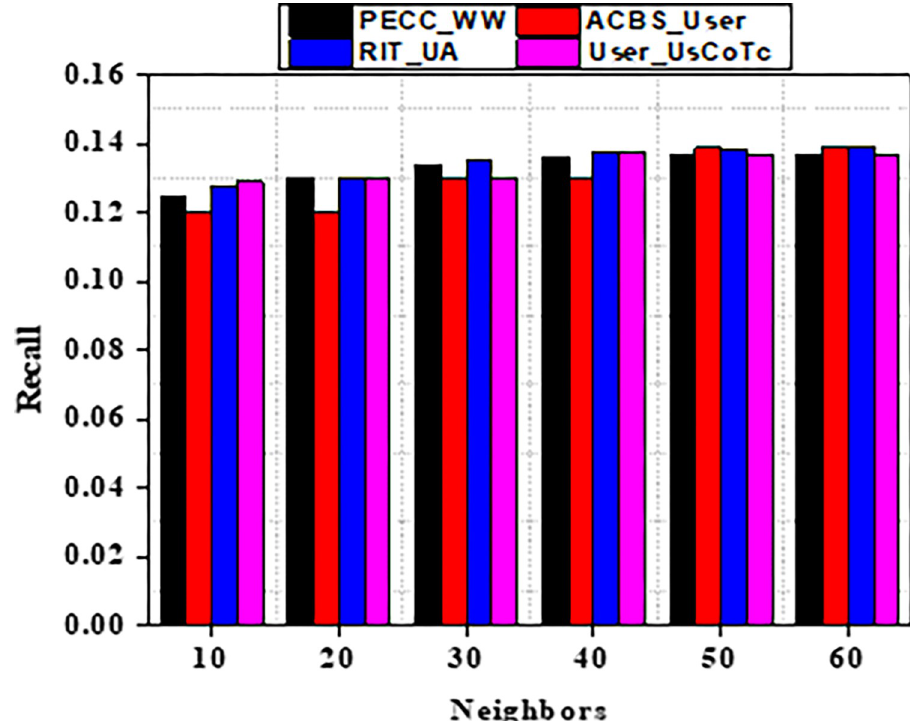
Fig 14. Recall with various